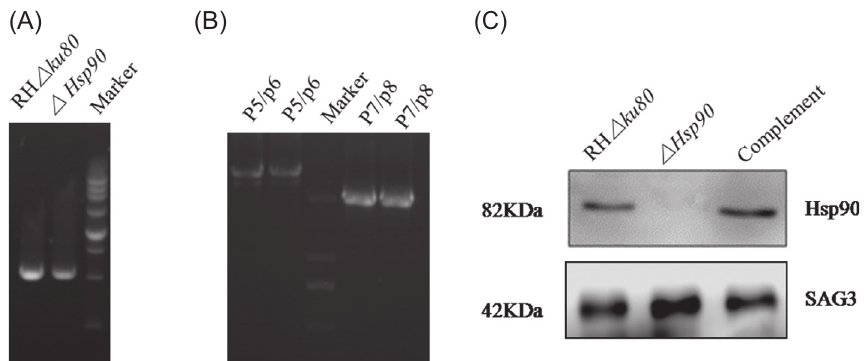
Figure 2. Confirmation of D Hsp90 and complemented parasites. (A, B) PCR analysis of D Hsp90 strains. The positions of the primers are shown in Figure 1A. P5/P6 and P7/P8 were used to amplify the conjunct regions of 5 0 and 3 0 integration of the Ble gene construct into the corresponding Hsp90 locus, respectively. (C) Western blotting analysis showing detection of Hsp90 in wild-type T. gondii RH D ku80 and in the complemented strain, but absence in D Hsp90 parasites. Surface antigen (SAG3) was used as a loading